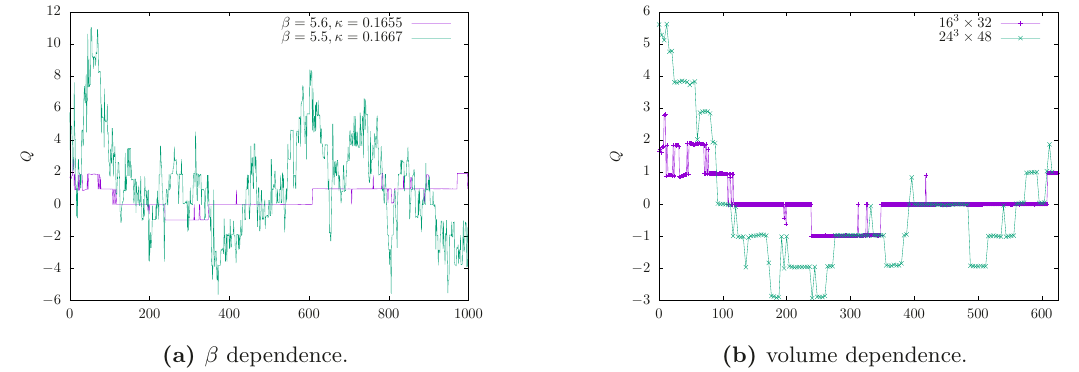
Figure 9. Left hand side: the history of the topological charge from simulations at β = 5 . 5 and β = 5 . 6 on a 16 3 × 32 lattice. Right hand side: the history of the topological charge at β = 5 . 6, κ = 0 . 1660 for two different